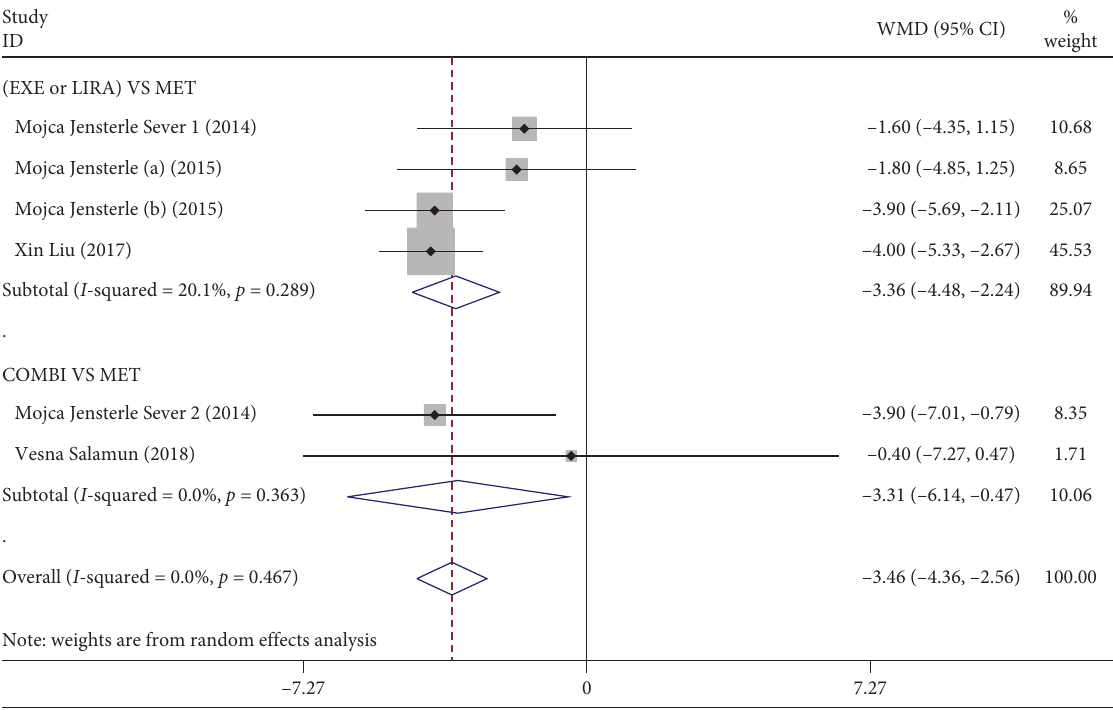
Figure 3: Forest plot of the outcome of waist circumference reduction effect in overweight/obese PCOS patients. EXE: exenatide; LIRA: liraglutide; MET: metformin; COMBI: combination, represented GLP-1RAs combined with MET treatment; WMD: weighted mean